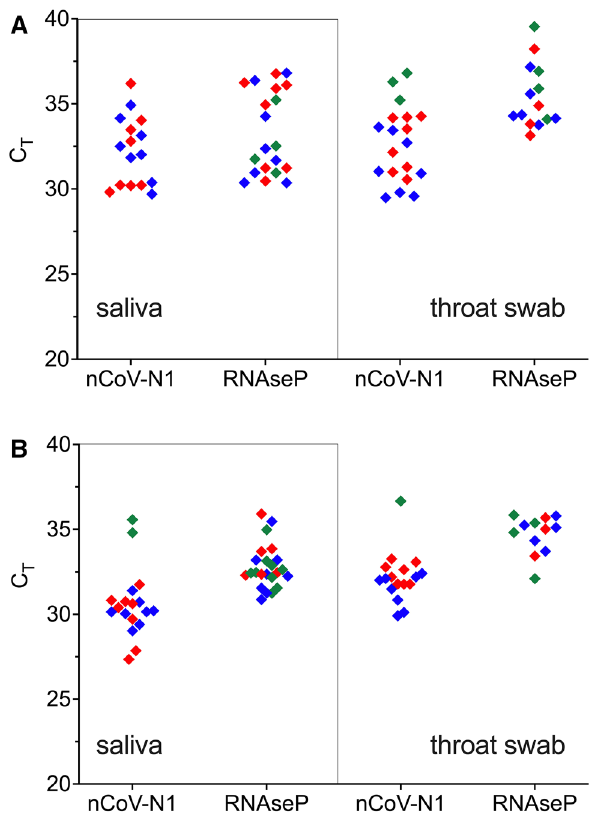
Figure 5. SARS-CoV-2 detection on hypothetical patient samples. Saliva and throat swab samples were collected from 24 volunteers and spiked 8 each with 1 × 10 5 copies/mL heat inactivated 2019 novel coronavirus (nCoV; blue diamond), VLPs (red diamond), or water (green diamond). Total RNA was extracted using ( A ) Opentron-2 and ( B ) Eppendorf epMotion. Biological samples were analysed by SYBR one-step RT-qPCR targeting SARS-CoV-2 N gene. Artefact amplification was observed in water-spiked saliva and throat swab samples (green